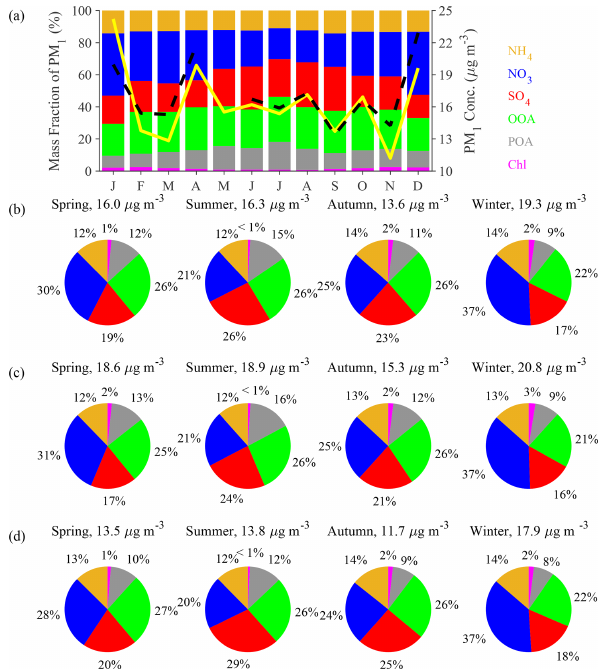
Figure 6. The monthly averaged (a) and seasonally averaged (b) – (d) mass fractions (%) of NR-PM 1 at SHT. The mass fractions (%) are calculated based on all (b) , daytime (c) , and nighttime (d) data. The monthly averaged mass concentrations (µgm − 3 ) of NR-PM 1 are also shown. The solid and dashed line represent SHARP PM 1 and NR-PM 1 ,